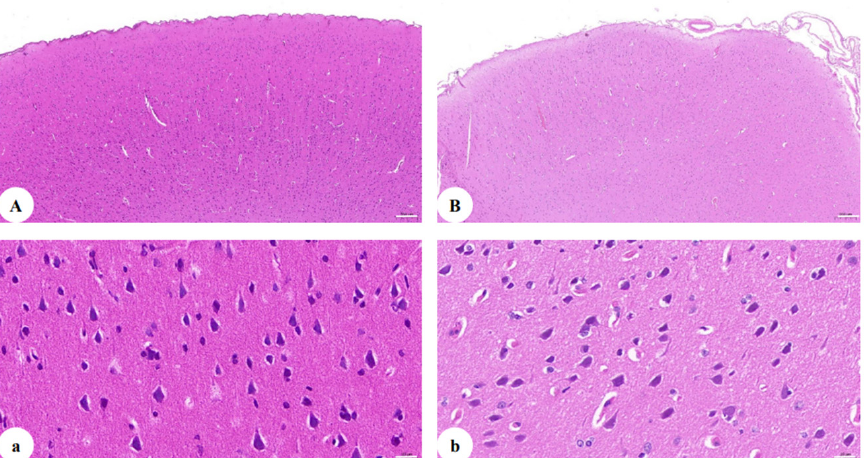
Figure 2. H&E staining of the cerebral cortex: ( A ) section of the cerebral cortex of healthy monkey (50×); ( B ) section of the cerebral cortex of the SHIV KU-1 -infected monkey brain (50×); ( a ) section of the cerebral cortex of healthy monkey (400×); ( b ) section of the cerebral cortex of the SHIV KU-1 -infected monkey brain (400×).